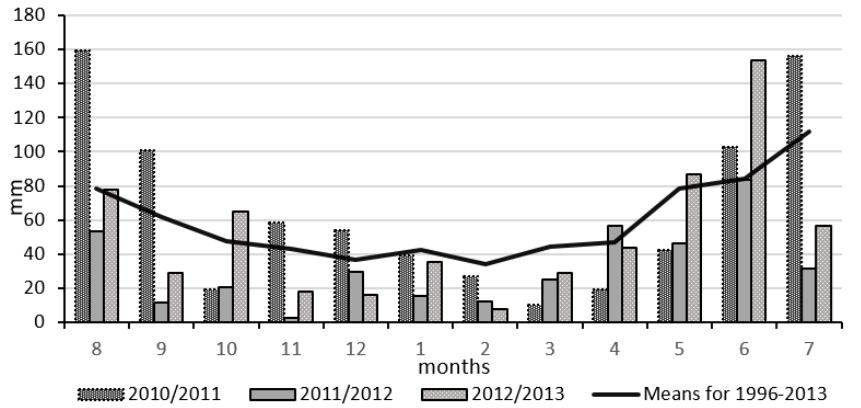
Figure 1. Rainfall in months (according to the COBORU Meteorological Station in Ulhówek) as compared to the long - term means (according to the meteorological station in Tomaszów Lubelski, Institute of Meteorology and Water Management — National Research Institute in Warsaw Meteorological Station).